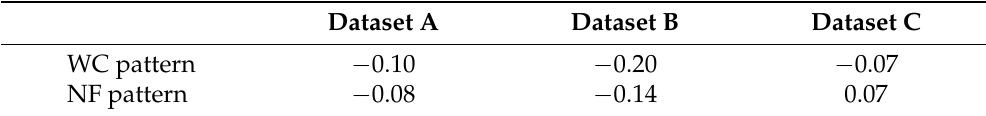
Table 6. Correlation coefficient between the number of positions and (cid:99) eps .